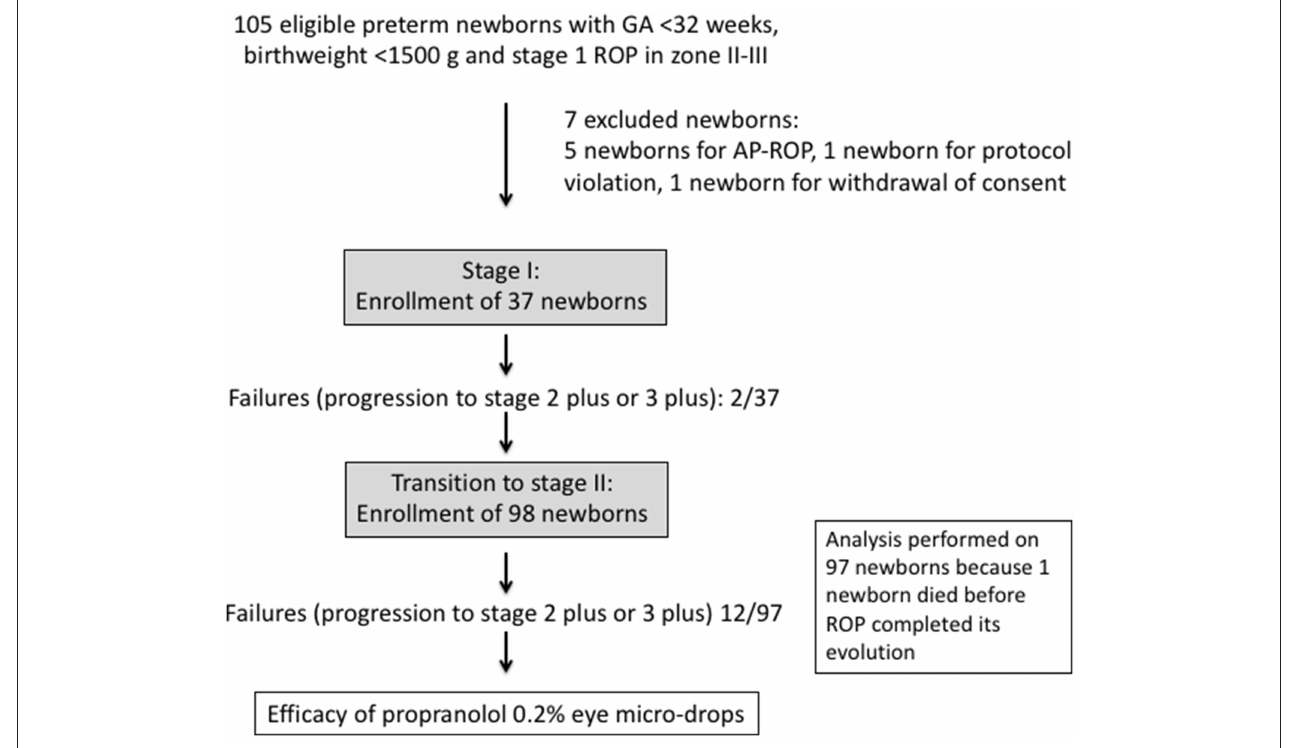
FIGURE 4 | Schematic representation of the results of the trial.